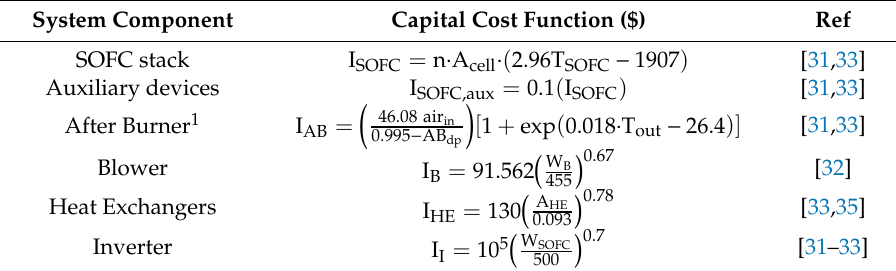
Table 7 together with the constant parameters included in the LCOE definition as expressed by Equation (9), specifically: